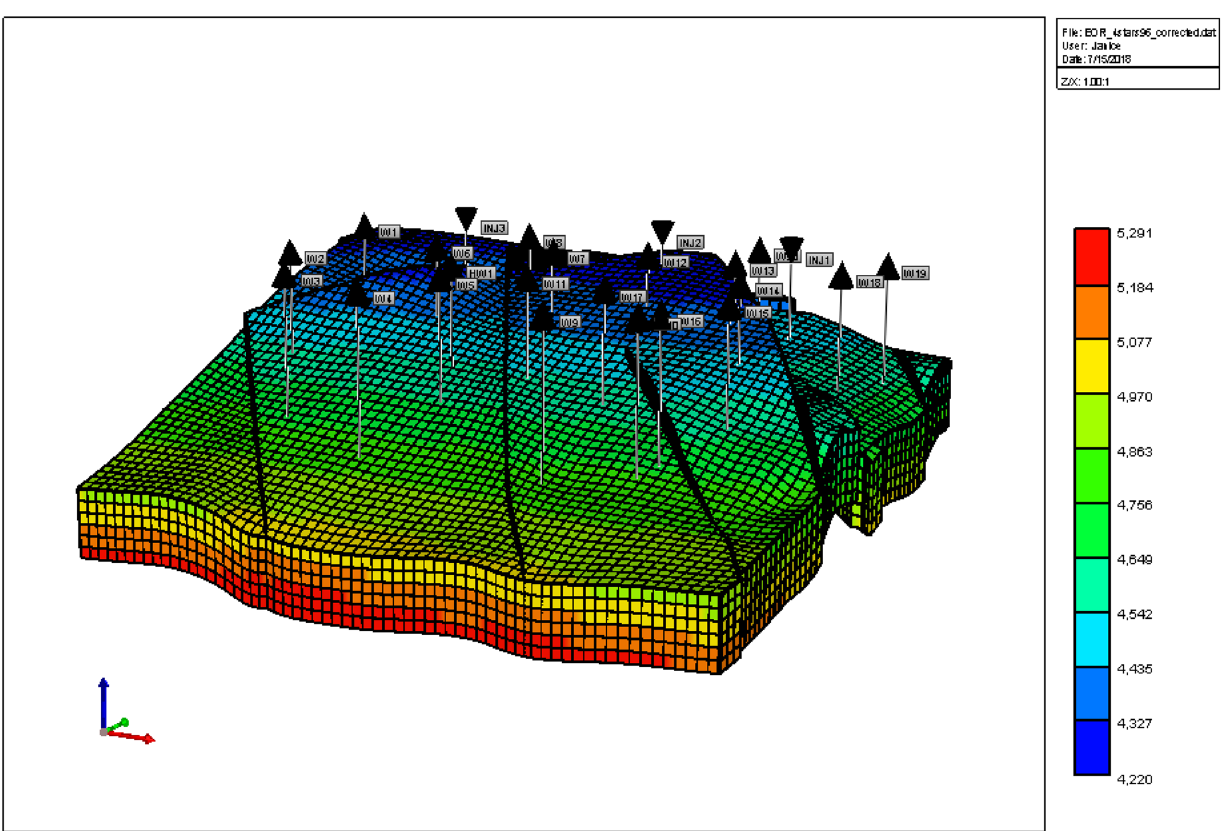
Fig. 5 3D view of reservoir model for EOR 4 Fig. 6 Typical calibration curve at 𝜆 max 340 nm for xanthan gum polymer solution containing 1%